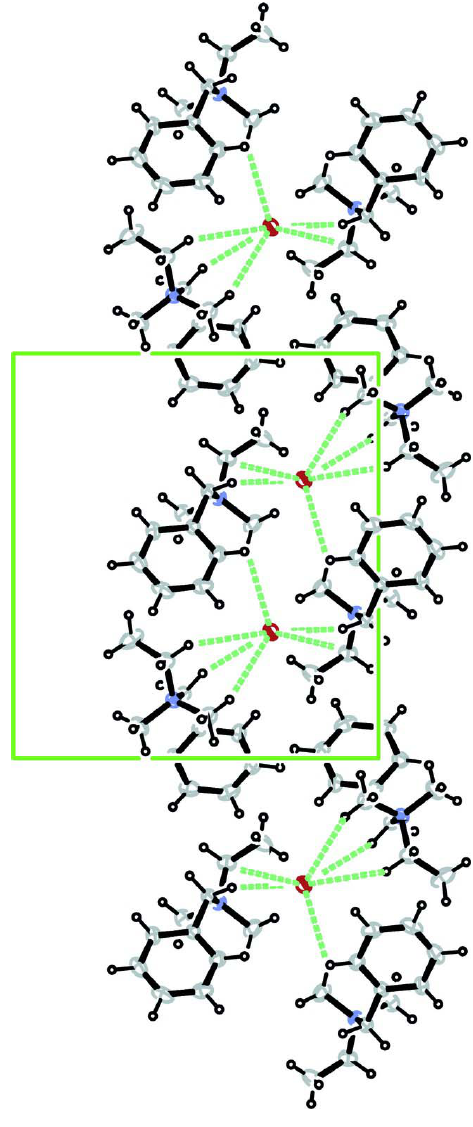
Layers parallel to (010) and built of the ammonium cations, arranged in a zig—zag 'head-to-tail′ system, are joined together through Br counterions. View along [100] ( ORTEP - 3 ; Farrugia,